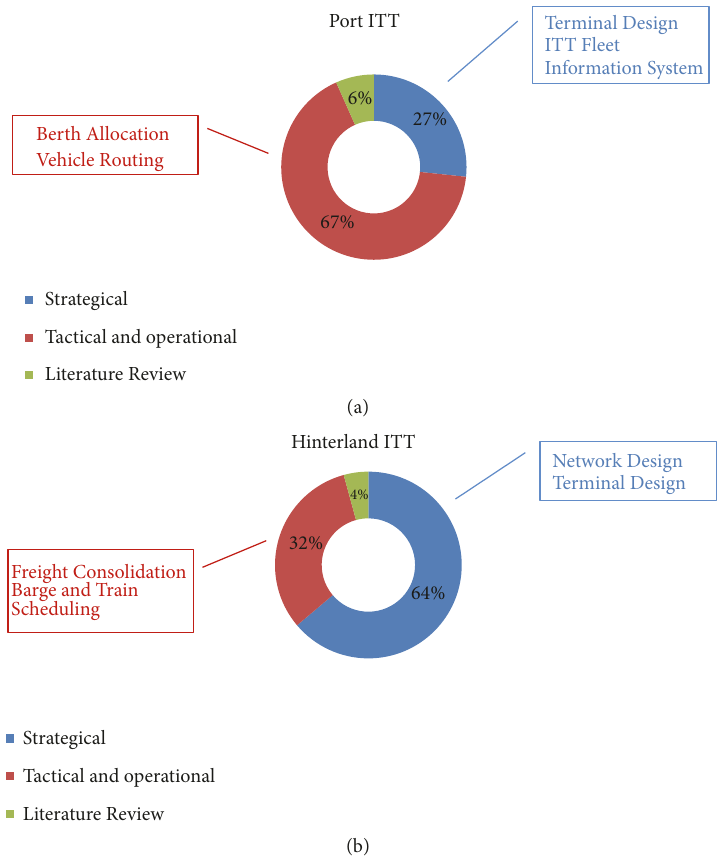
Figure 2: Research levels of port ITT (a) and hinterland ITT (b).